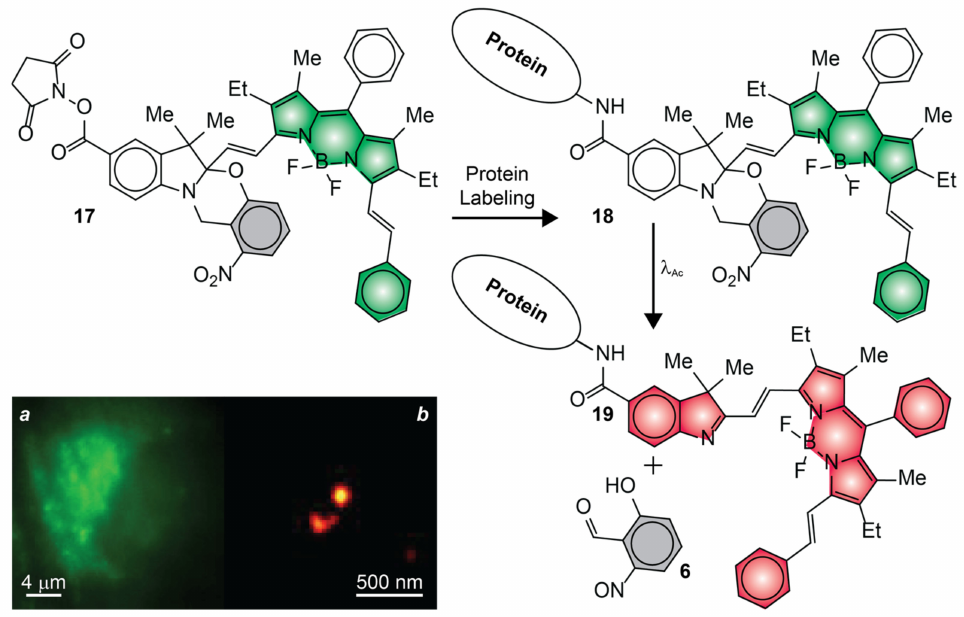
Figure 11. Diffraction-limited ( a ) and PALM ( b ) images of the lysosomes of live COS–7 cells, labeled with 17 [adapted with permission from Ref.